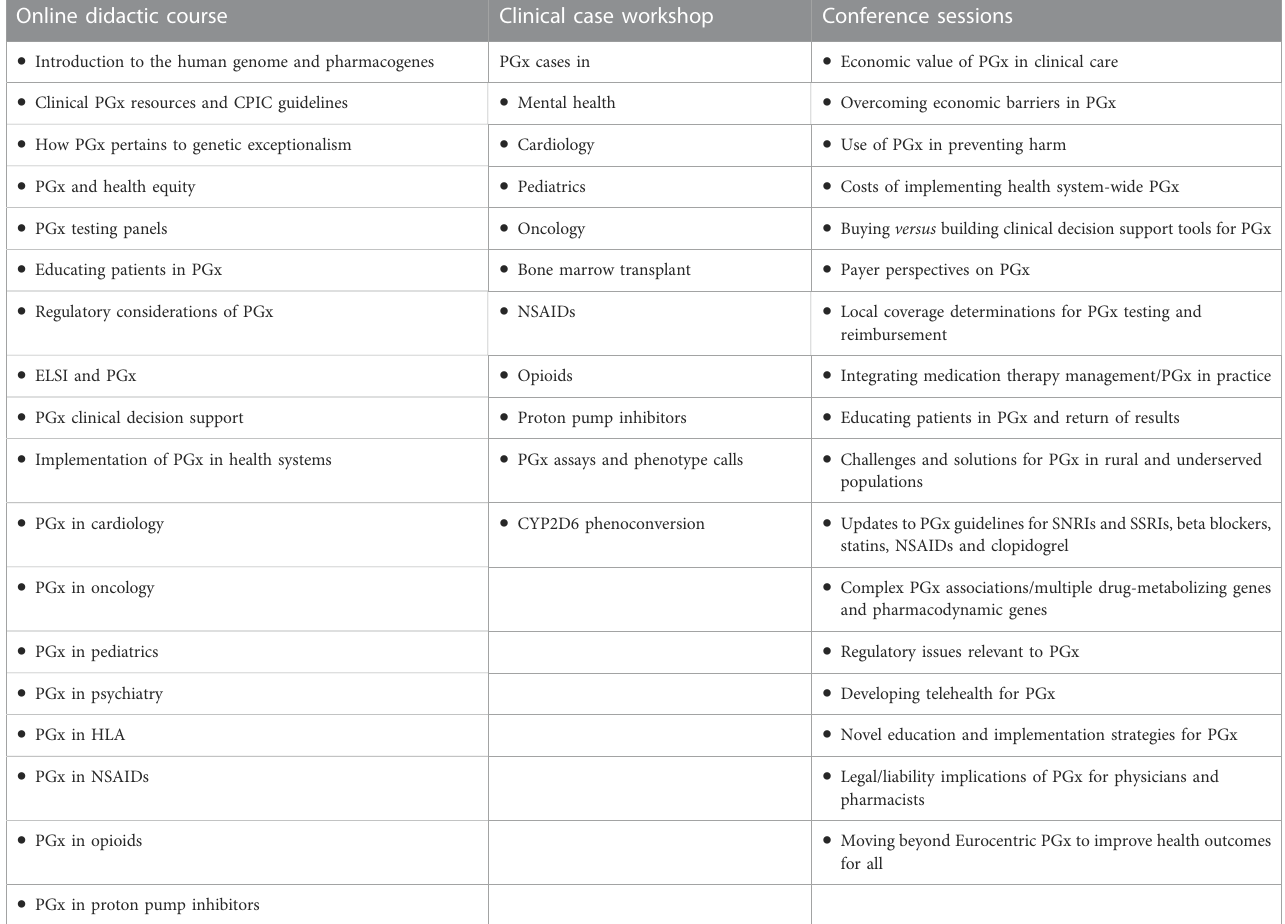
TABLE 2 Topics covered in online didactic course, clinical case workshop and national conference sessions. Online didactic